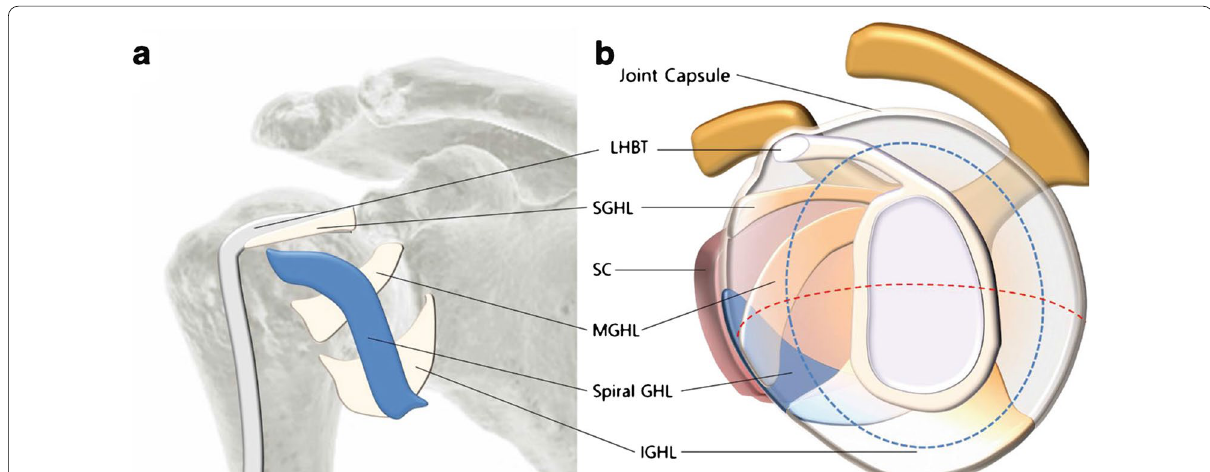
Fig. 1 Anatomy of the shoulder joint capsule structure and demonstrations of measurements of anterior joint capsule thickness on MRI. a Frontal illustration of outer side of glenohumeral ligament and b lateral view of inner aspect of shoulder joint capsule and glenohumeral ligament. The red dashed line demonstrates the axis of the axial MRI images and the blue dashed line demonstrates the axis of the sagittal MRI images. Quoted from Park et al.